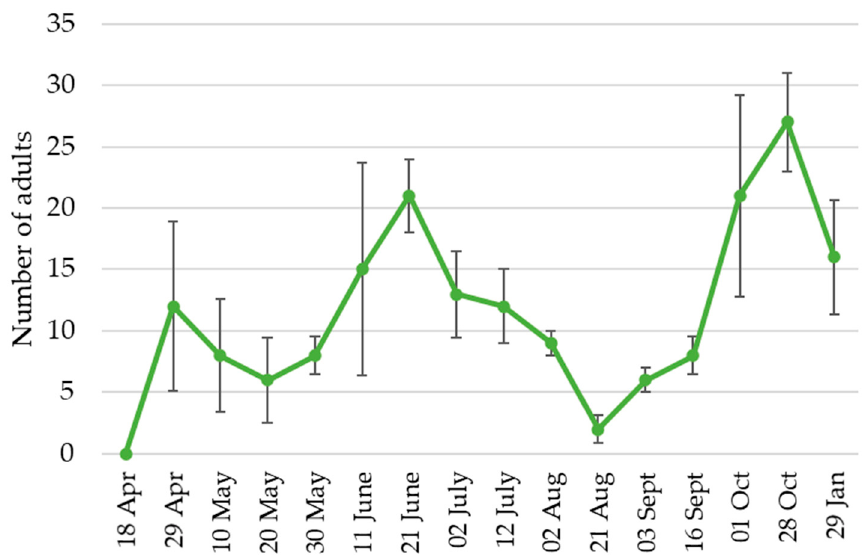
Figure 6. Seasonal fluctuation of black weevil Aclees taiwanensis adults in Tuscany (Italy) orchards during 2019. Bars represent standard deviations.